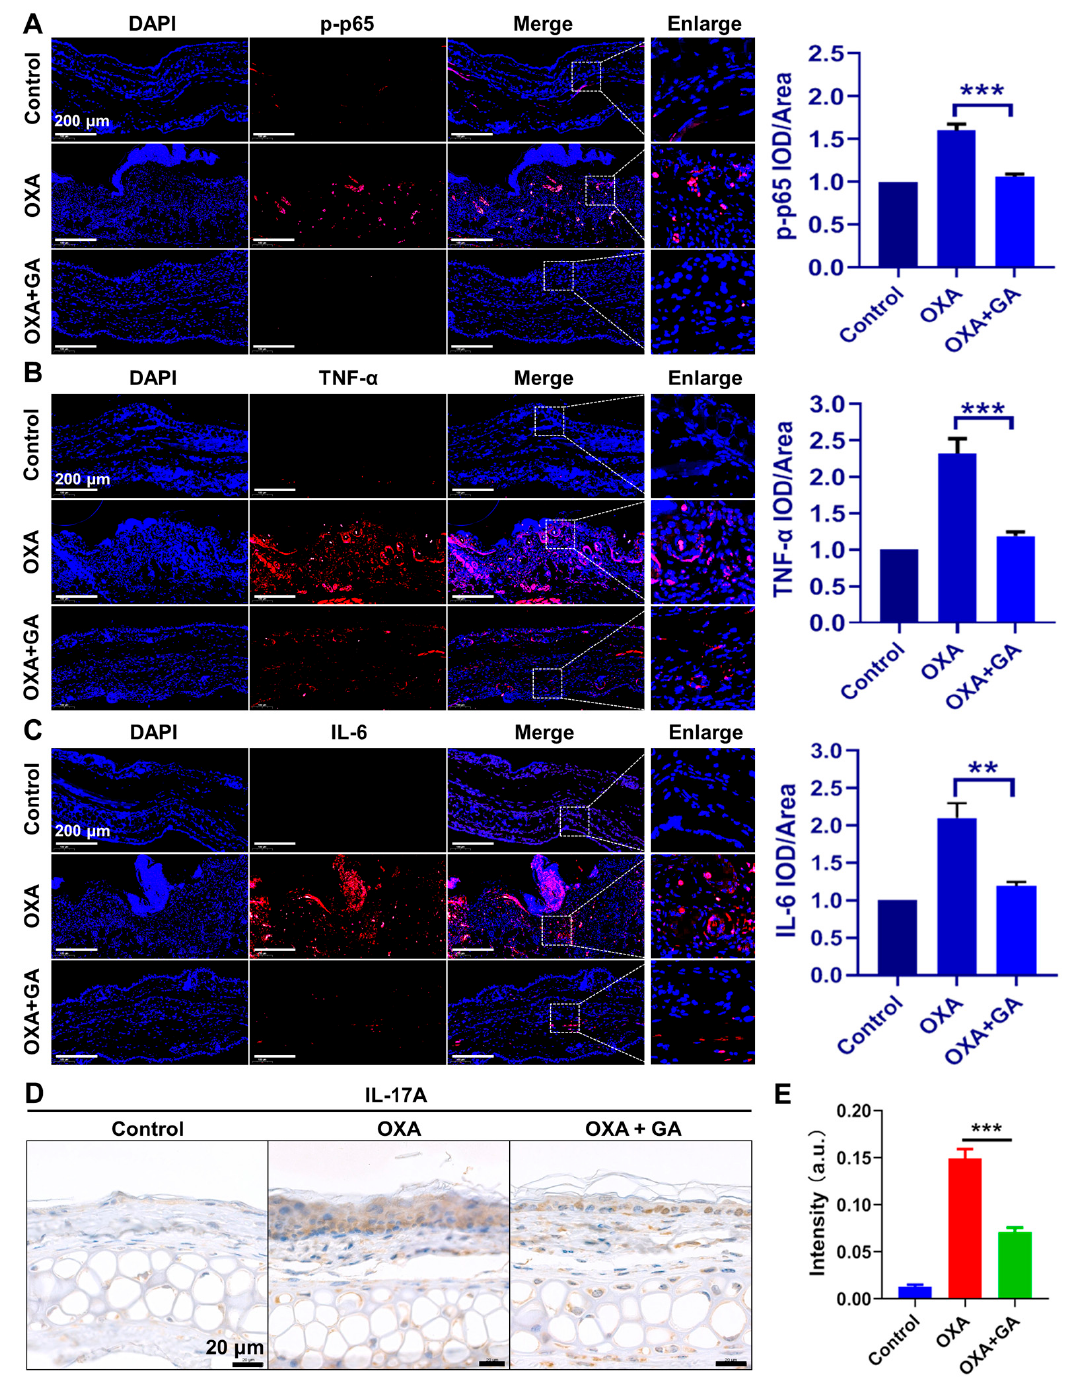
Figure 6. Effect of AuNCs on the TNF- α /NF- κ B/IL-17A axis in psoriasis-like mice. In the OXA-induced psoriasis model, immunofluorescent detection of ( A ) p-p65, ( B ) TNF- α and ( C ) IL-6 is shown in red, whereas DAPI was used to stain the nucleus in blue. The magnification for all images is the same. Magnification = 20×, Scale bar = 200 µm. ( D ) OXA-stimulated mice ear sections were stained for IL-17A. Scale bar = 20 µm. ( E ) The intensity of IL-17A staining in each group was qualitatively analyzed. The data are presented as mean ± SD of triple tests, ** p < 0.01, *** p < 0.001.